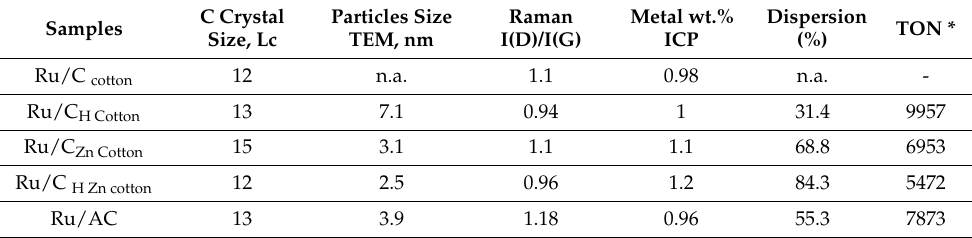
Table 3. Average carbon and ruthenium size, I(D)/I(G) Raman ratio, metal loadings, and dispersion. C Crystal Particles Size Raman Metal wt.% Dispersion Samples TON * Size, Lc TEM, nm I(D)/I(G) ICP (%) Ru/C cotton 12 n.a. 1.1 n.a. Ru/C HCotton Ru/C ZnCotton Ru/C